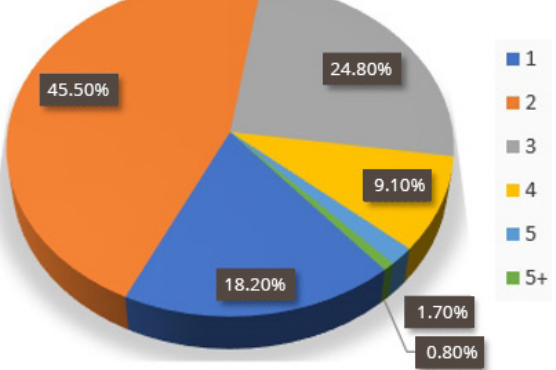
Figure 2. Frequency pie chart of number of founders.